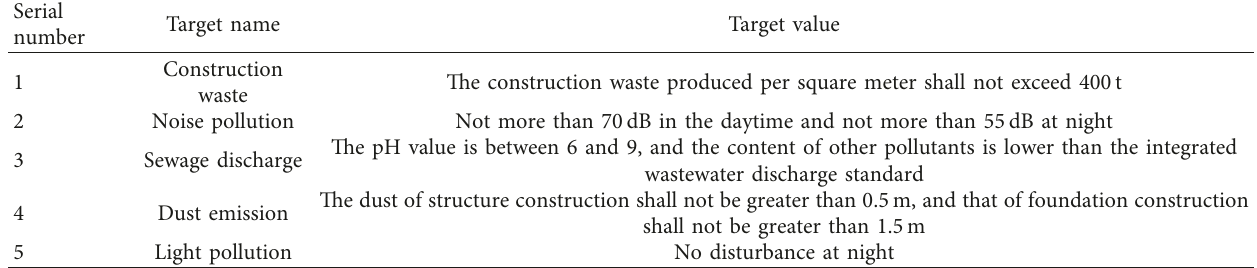
Table 2: National building pollution